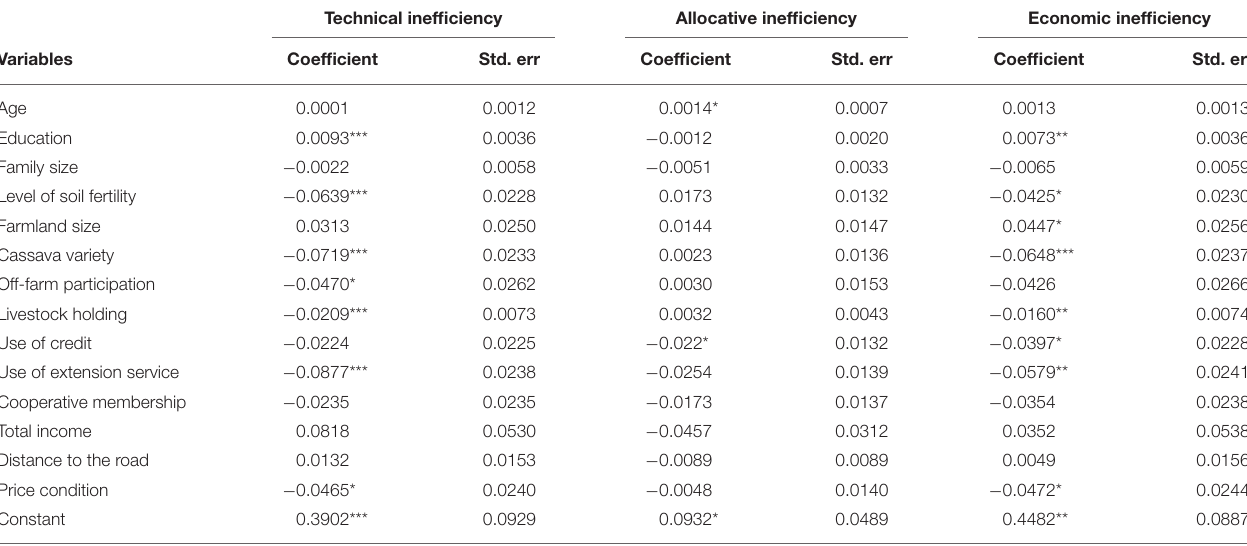
TABLE 9 | Tobit model estimates for sources of